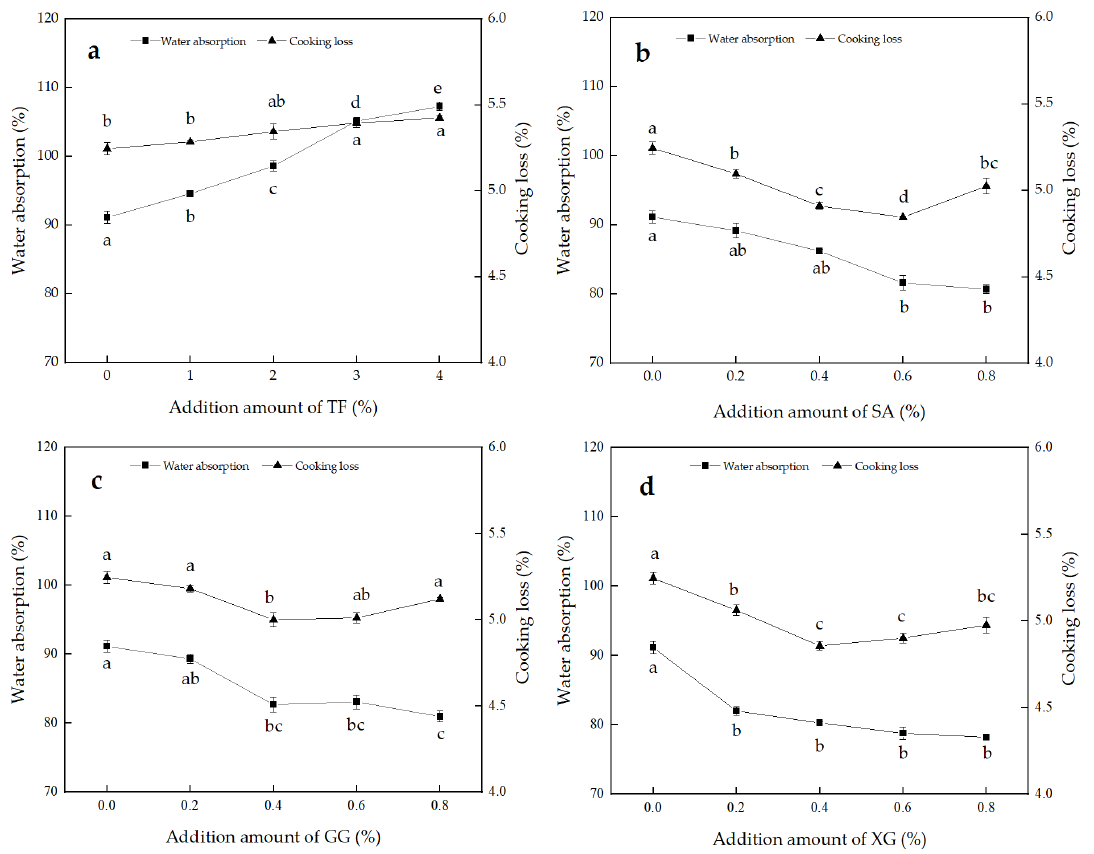
Figure 2. Effect of TF ( a ), SA ( b ), GG ( c ), and XG ( d ), on water absorption and cooking loss of noodles. Note: All experiments were carried out in triplicate according to independent replicate experiments, and the results were reported as mean value ± standard deviation. Values with the same superscript letters in in different figures are not significantly different at p < 0.05.